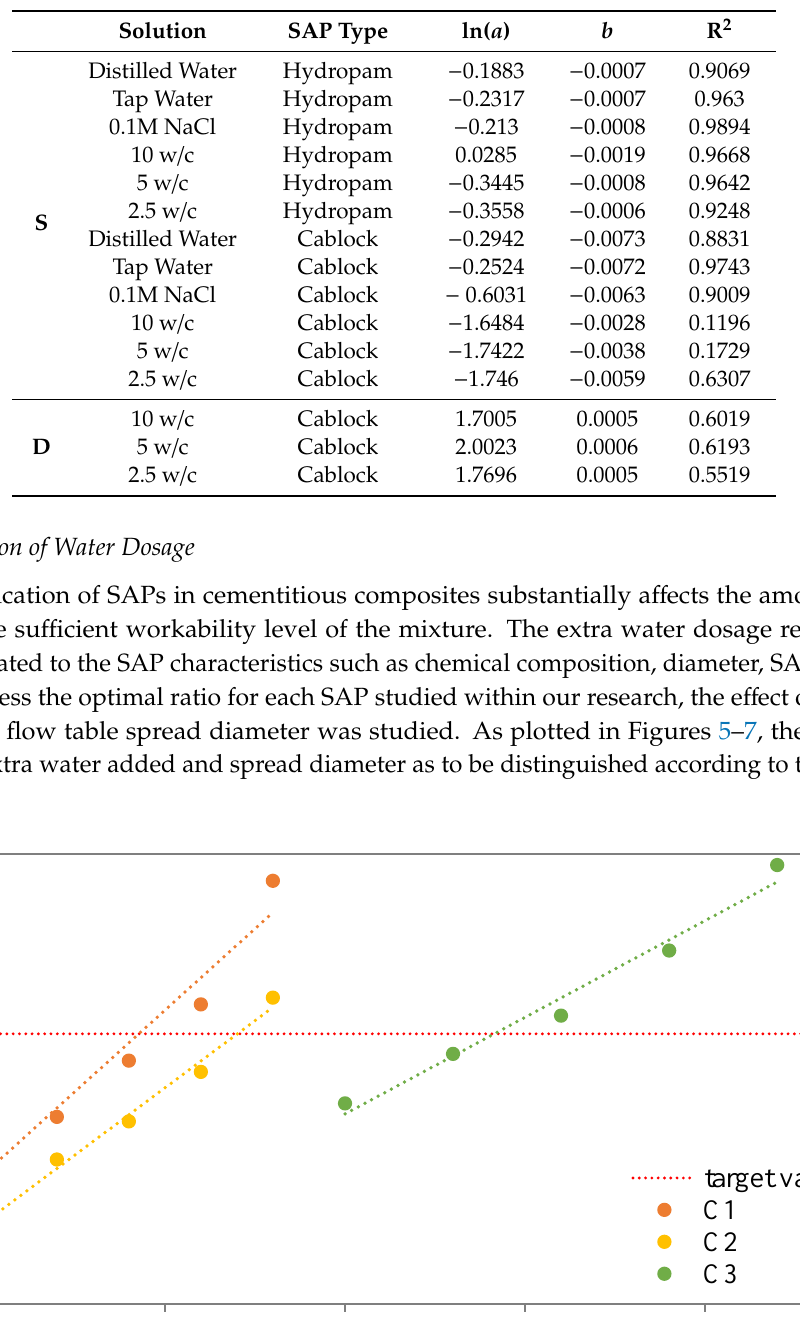
Table 2. ln( a ) and b coe ffi cients depending on used solution–SAP system.